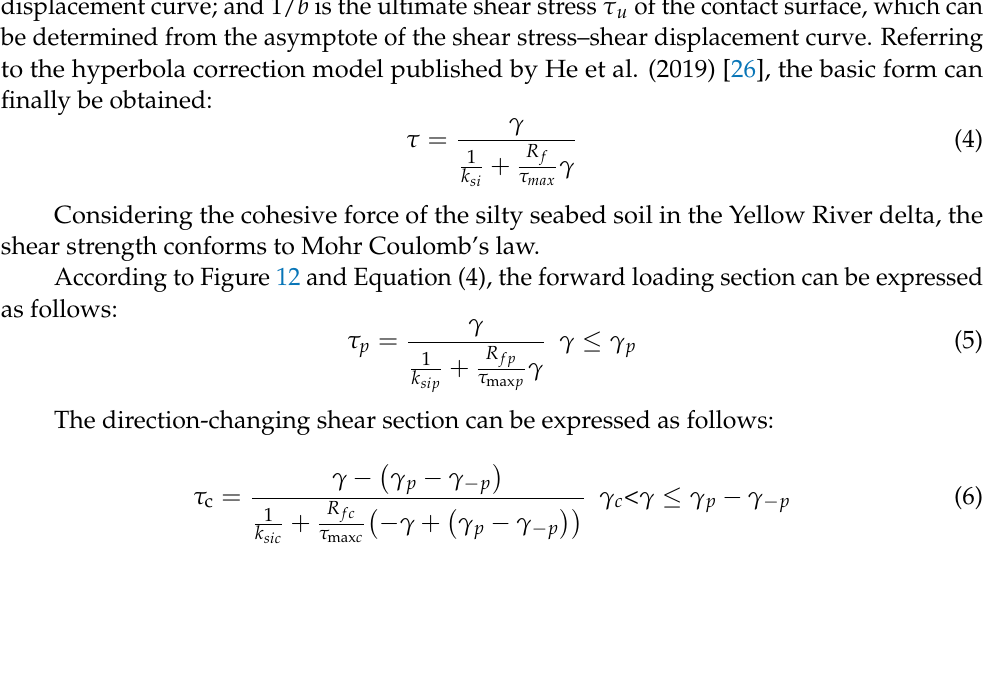
Figure 13. Cyclic shear hysteresis.